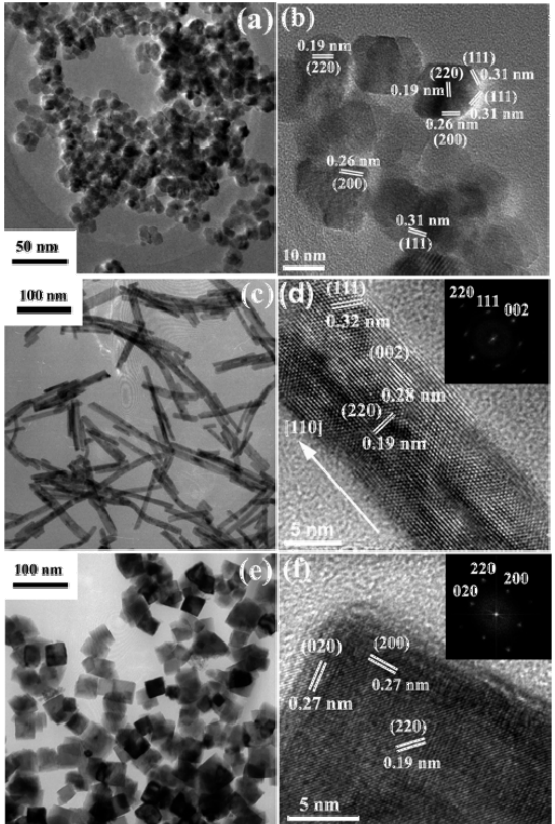
Figure 1. TEM ( a ) and HRTEM ( b ) images of CeO 2 nanopolyhedra. TEM ( c ) and HRTEM ( d ) images of CeO 2 nanorods, inset is a fast Fourier transform (FFT) analysis. TEM ( e ) and HRTEM ( f ) images of CeO 2 nanocubes, inset is a FFT analysis. Reproduced from Ref. [70] with the permission from ACS